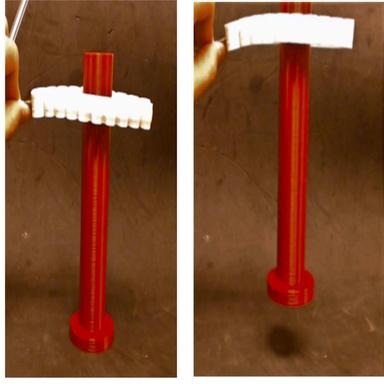
Grip functionality under a pressure of 25 psi.